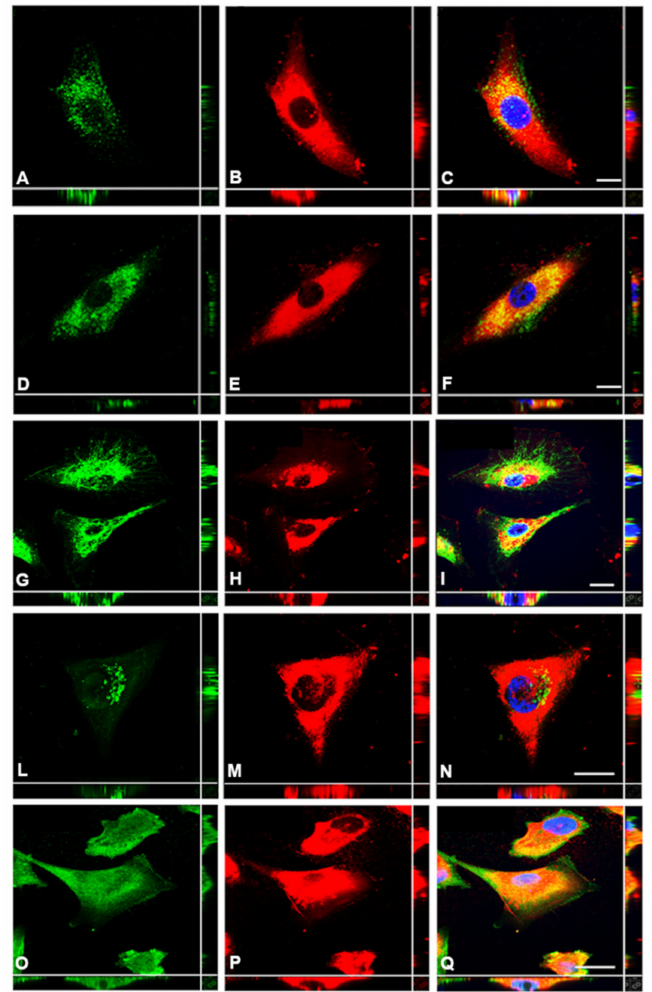
Figure 4. Intracellular HA distribution along endocytic and secretory pathways. MPM primary cells were fixed, permeabilized and co-stained for the HA-binding protein ( B , E , H , M , P ) and markers of the endocytic pathway, EEA1 ( A ) and Lamp-1 ( D ), as well as for secretory pathways, calnexin ( G ), TGN38 ( L ) and Rab11A ( O ). The overlap allowed excluding colocalization along the endocytic pathway ( C , F ), low intensity of colocalization for calnexin ( I ) and TGN38 ( N ) and stronger intensity for Rab11A ( Q ). Scale bar: 10 µ